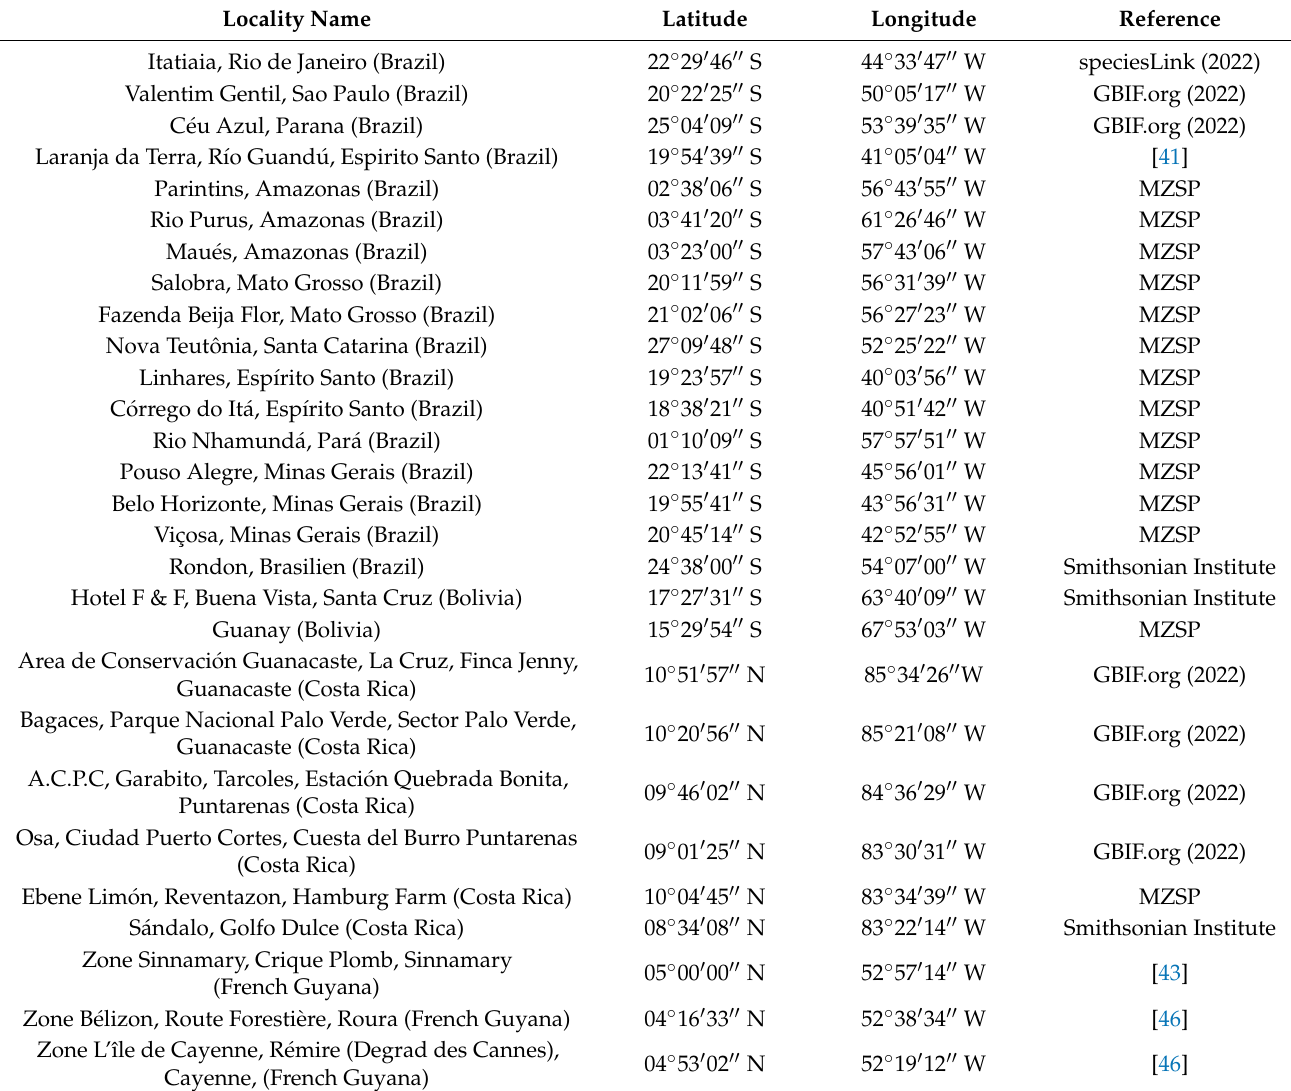
Table 1. Known records of Lepturges limpidus in the Neotropics sorted by locality, country and geographic coordinates. Locality Name Latitude Longitude